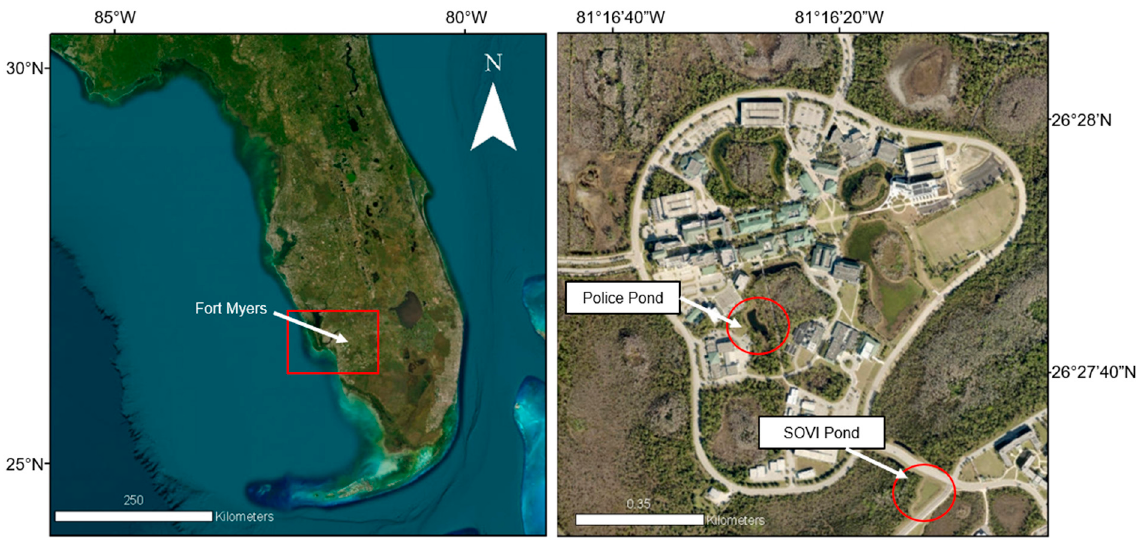
Figure 1. Location map showing the location of Fort Myers, Florida ( left ) and the stormwater pond locations on the campus of Florida Gulf Coast University ( right ).